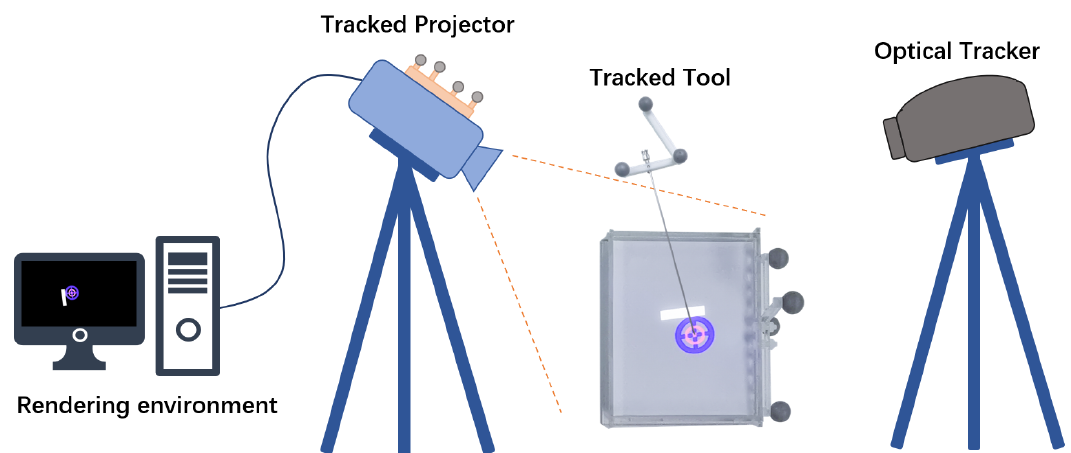
Figure 1. Overview of the system. The surgeon carries out puncture operation under navigation.